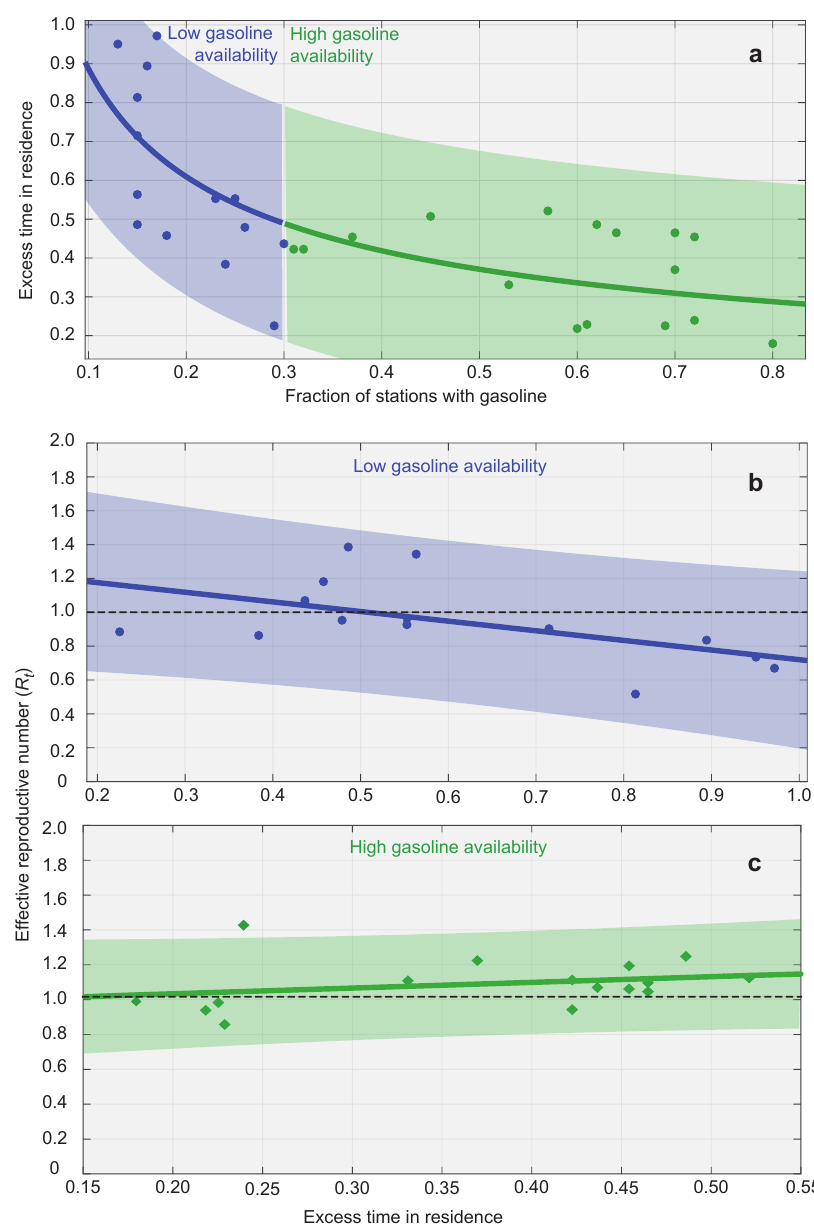
Figure 5. Drivers of contagion in Venezuela. ( a ) Excess time spent at home relative to pre-pandemic (Google Mobility) decreases with the availability of gasoline according to y = 0.2536 ∗ x − 0.5487 . This dependence was stronger when gasoline availability dropped below 30% (orange area), than when it was above this threshold (green area). ( b ) When gasoline availability decreased below 30%, the effective reproductive number decreased significantly with the excess time spent at home ( R 2 = 0.29, F ( 1,13 ) = 4.91, p = 0.046). ( c ) When gasoline was available in more than 30% of stations, the effective reproductive number no longer showed a significant relationship with excess time spent at home ( R 2 = 0.07, F ( 1,13 ) = 1.12, p = 0.278). Two outliers with R t > 2 were omitted from the